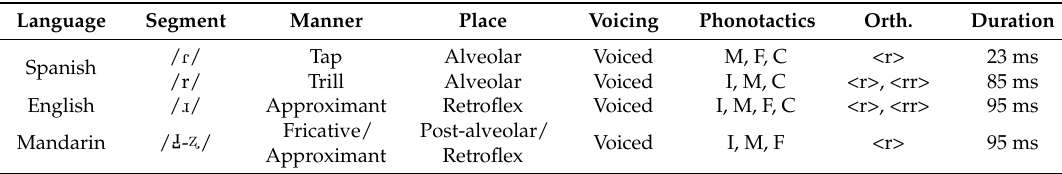
Table 1. Comparison of Spanish, Mandarin, and English